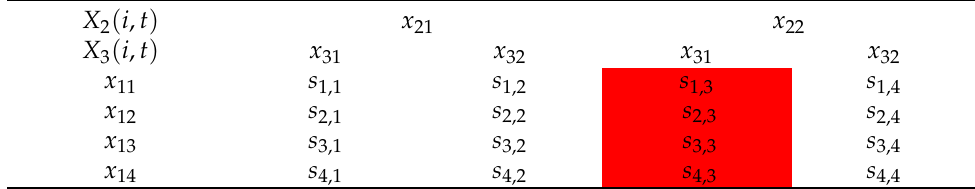
Table 5. CPD of the epidemiological state.